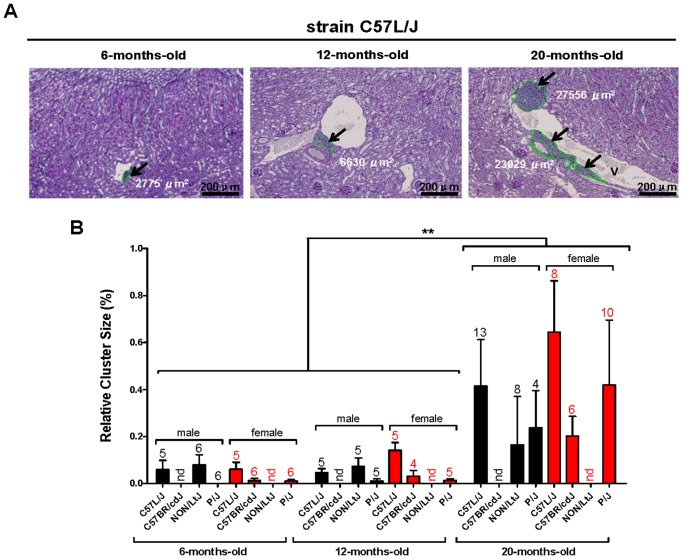
The size of renal perivascular immune cell clusters increase with age.(A) Representative photomicrographs (PAS staining) of perivascular cell clusters in kidneys obtained from C57L/J mice at the age of 6, 12 and 20 months. Cell cluster surface area was calculated and expressed in μm2 as indicated (magnification 100x). Arrows indicate individual perivascular infiltrates. Abbreviation: v: vein. (B) Perivascular immune cell clusters were measured in 6-, 12- and 20-months-old male (C57L/J, NON/LtJ, and P/J strains) and female (C57L/J, C57BR/cdJ and P/J strains) mice and expressed as relative cluster size (as described in
Materials & Methods
). Data expressed as mean ± SEM. Numbers indicated above each bar represent the number of mice analyzed. Strains from which no tissues were available are marked as nd (not determined). No differences between 6-months-old and 12-months-old mice in both sexes were observed. However, a significant increase in relative cluster size was observed in 20-months-old mice compared with both 6-months-old and 12-months-old mice (**P<0.01).